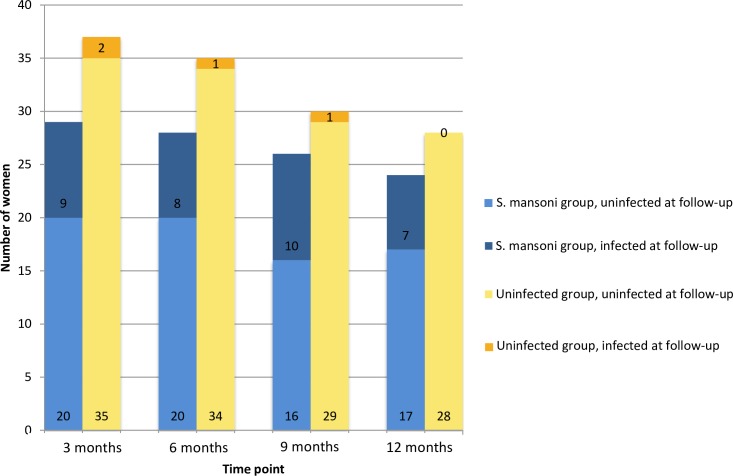
Number of women from each group who were seen at each follow-up time point, and their infection status.Blue bars represent women who were S. mansoni-infected at enrollment. Yellow bars represent women who were uninfected at enrollment. Darker color indicates the proportion of women who were S. mansoni-infected at the time point shown.